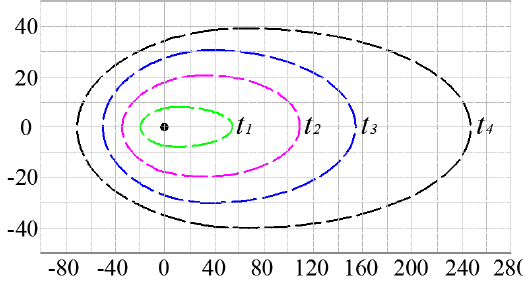
Figure 5. Grouting diffusion traces at a representative time (type 1).